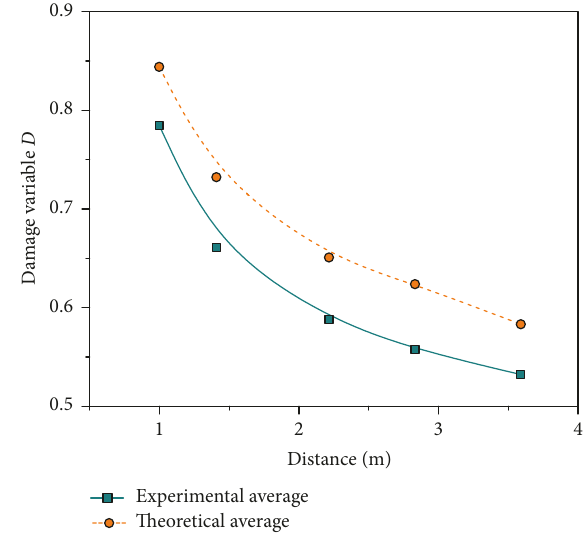
Figure 8: Particle vibration velocities for various distances between blasting source and sonic wave monitoring hole.